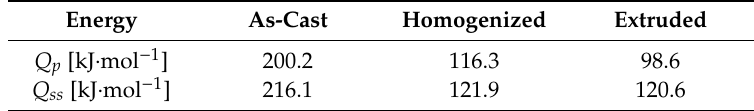
Table 2. Hot deformation activation energy values calculated for various structural states.